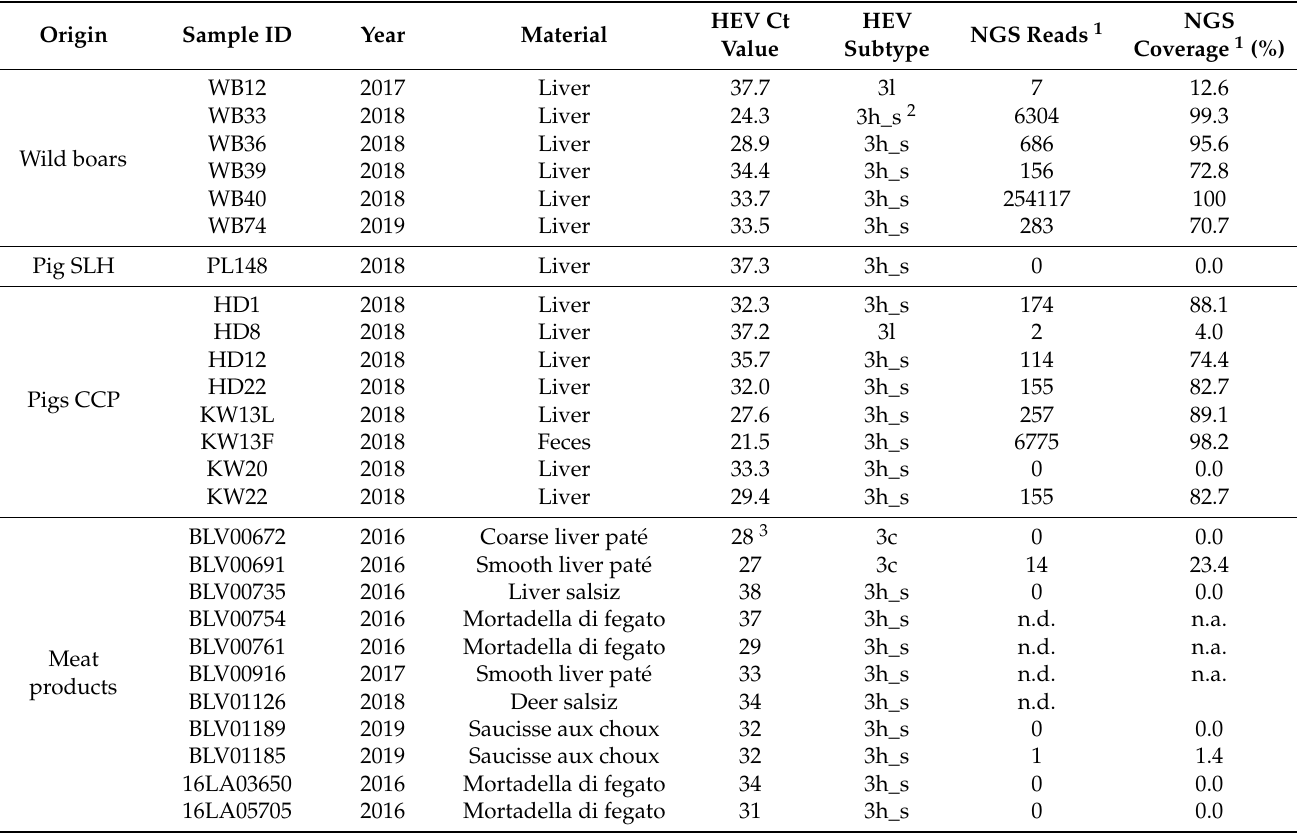
Table 2. Overview of the samples with successful partial ORF2 sequencing, the year of sampling, real-time RT-PCR Ct values, the subtype allocation and the NGS